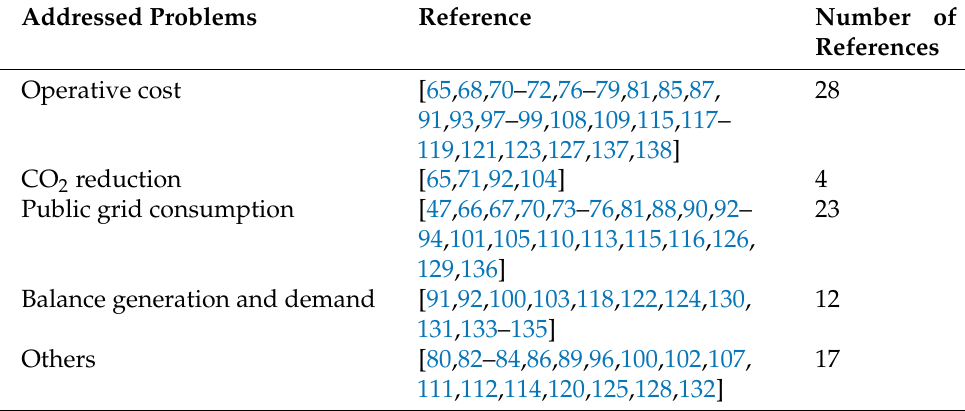
Table 3. Summary of the addressed problems in energy management in